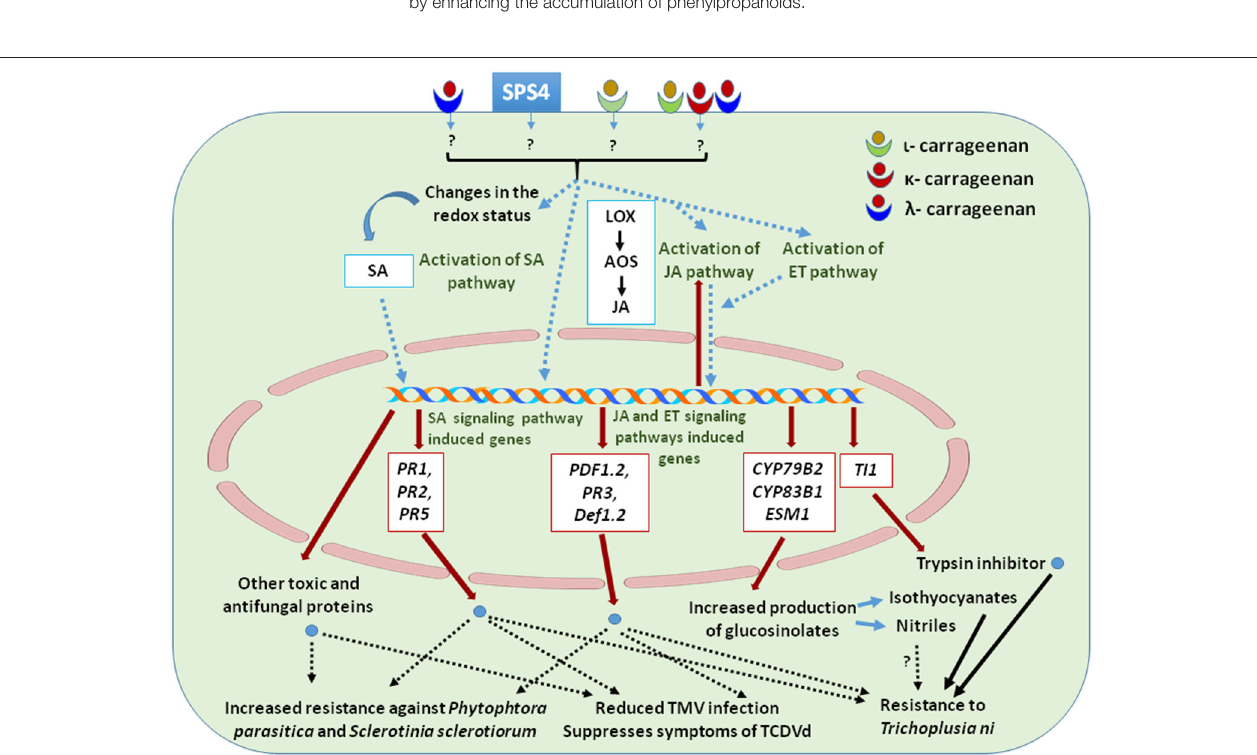
FIGURE 2 | Cellular functions and signaling pathways involved in defense mechanisms elicited by carrageenans applications that resulted in increased resistance to pathogens. The drawing summarizes most of the information presented in Section Plant Defense.